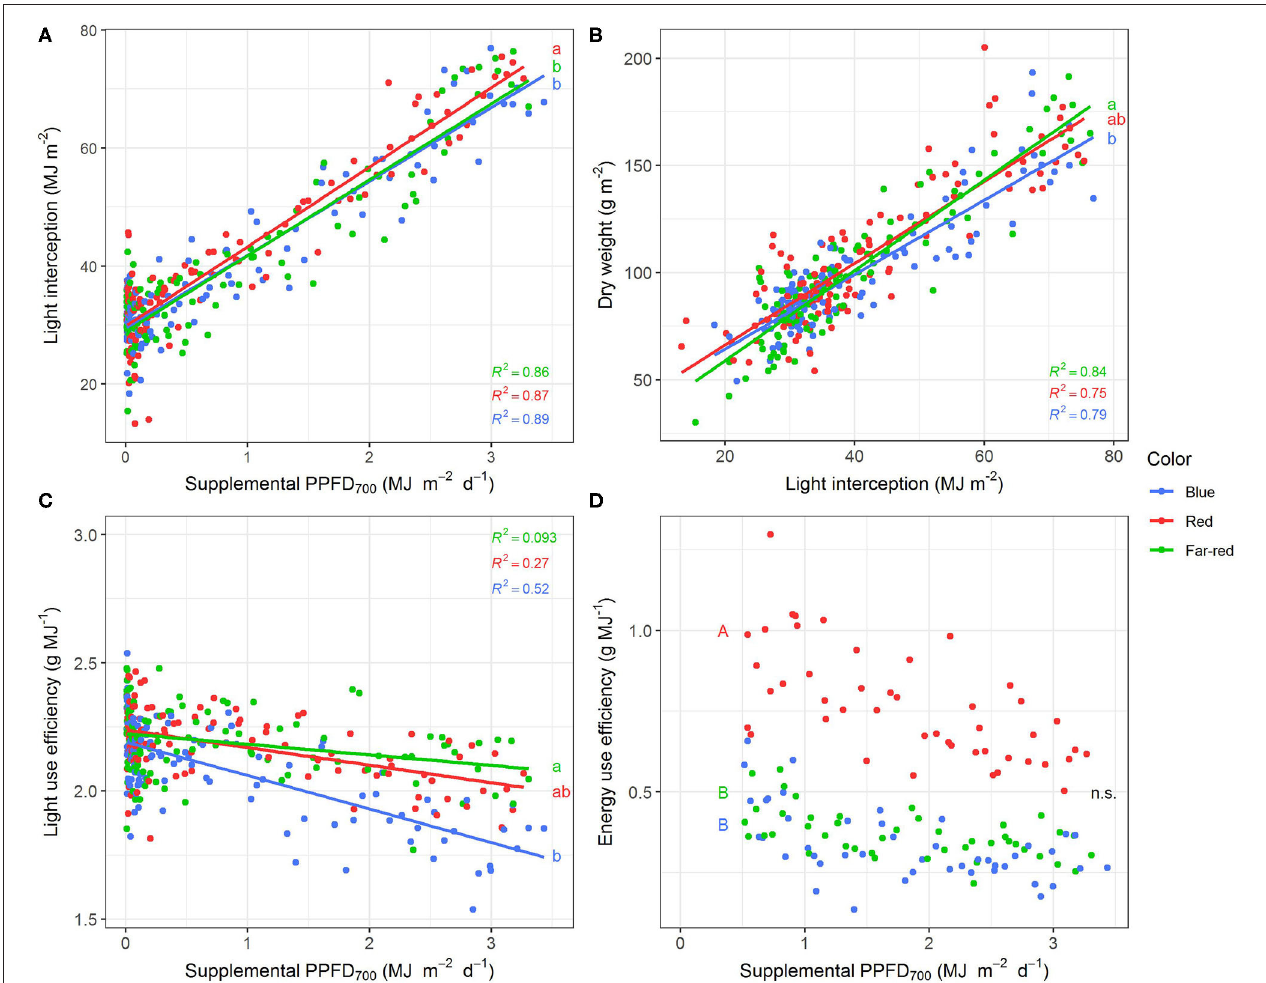
FIGURE 4 | Effect of supplemental PPFD 700 (400–700nm) with different spectra on light interception (A) , dry weight (B) , light use efficiency (C) , and energy use efficiency (D) of Ocimum basilicum L. cv. “Edwina” cultivated under greenhouse conditions. Different lower-case and upper-case letters indicate significant differences in slopes and intercepts between colors ( p < 0.05; n.s., non-significant), respectively. Intercepts of (A–C) were not significant. Linear regression lines of each light color are indicated. Regressions are based on 120 plants per treatment, each with a specific light dose. Each data point shows an average of the four seasons, two harvest points and two experimental